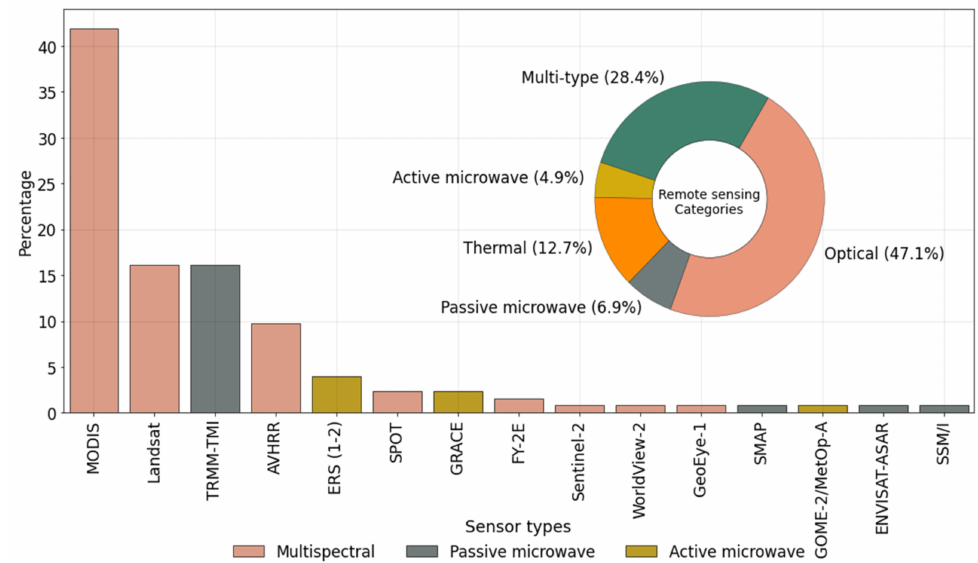
Figure 10. Various sensors used for drought monitoring and assessment. The color codes represent the types of sensors in the bar plots, while the pie chart indicates the percentage of articles associated with each remote sensing